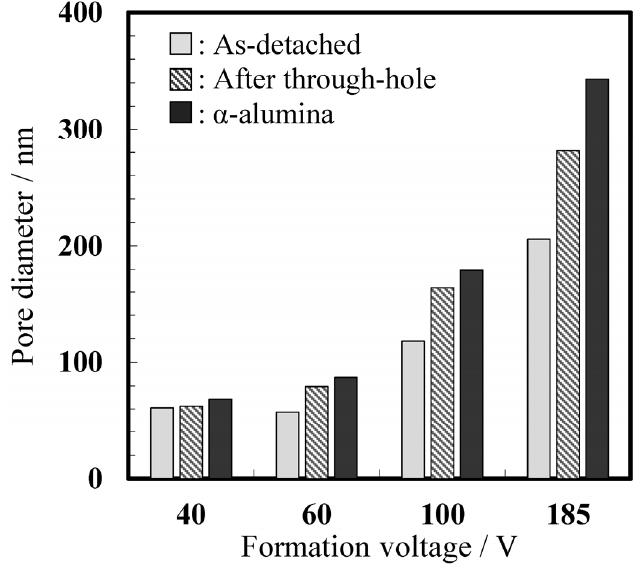
Figure 7. Changes in the pore diameters of the top surfaces of alumina membranes after through-hole and subsequent heat treatment. The chemical dissolution of the alumina membranes formed at 40, 60, 100, and 185 V was performed in 5 wt% phosphoric acid at 30 °C for 5, 30, 60, and 120 min,